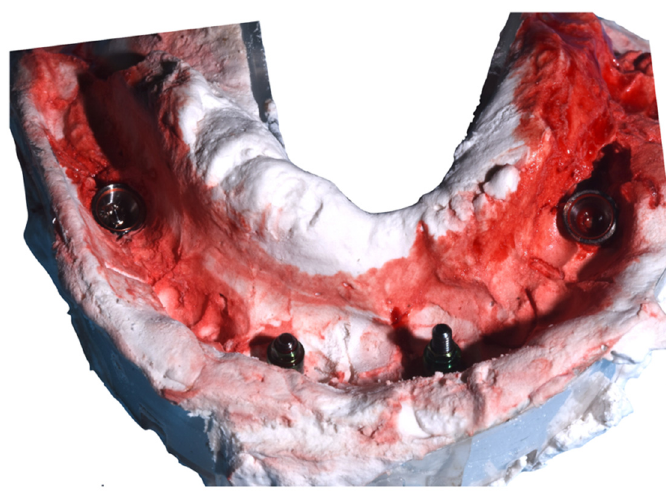
Figure 7. Plaster